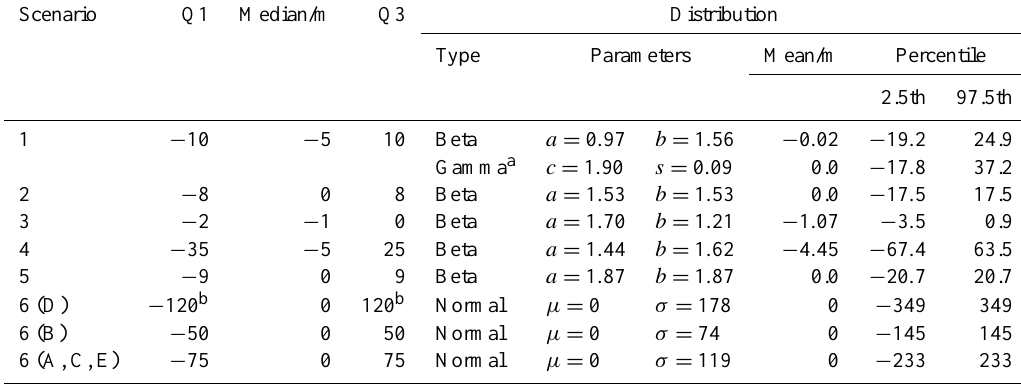
Table 2. Group quantiles for each scenario and best-fitting